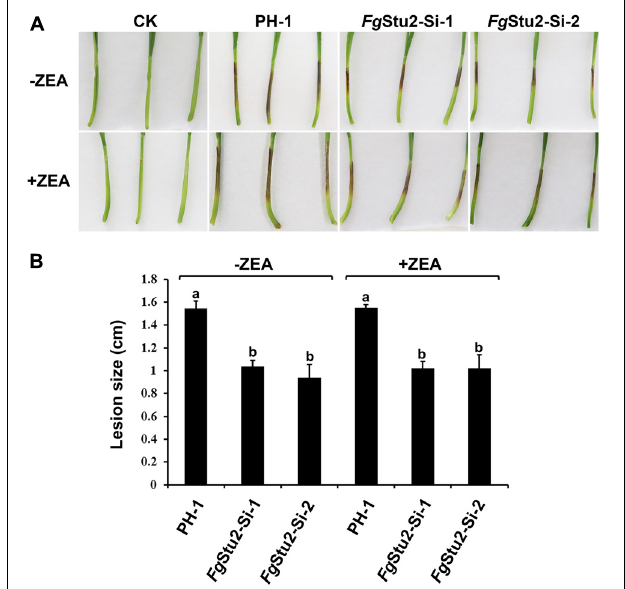
FIGURE 8 | Roles of Fg Stu2 gene in pathogenicity. (A) Infected wheat coleoptiles were photographed at 7 days after inoculation. The small solid arrows indicate the inoculation sites and the hollow arrow indicates the lesion development direction. (B) Lengths of brown lesions of wheat coleoptiles. Values are means ± standard deviation of three repeated experiments. Means of the column with the same letter are not significantly different ( P <